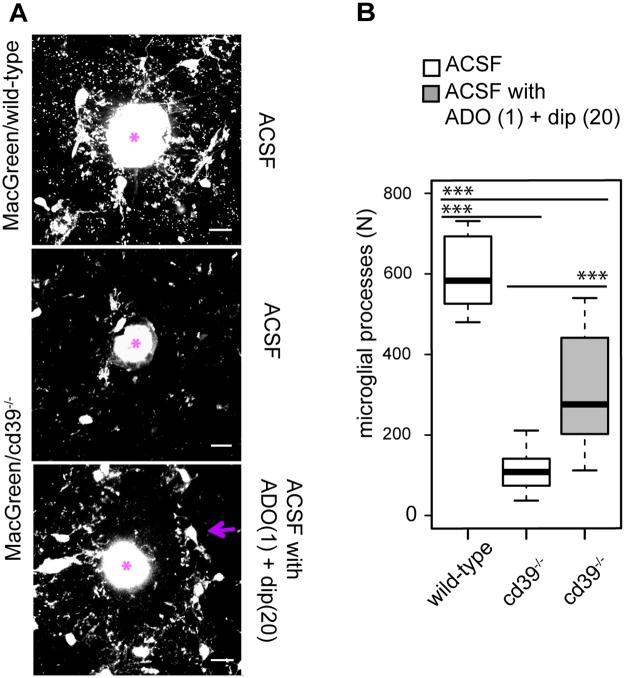
Extracellular adenosine is required for a directional movement of microglial processes towards a focal laser lesion in acute brain slice.(A) Accumulation of microglia processes around a focal laser lesion in an acute brain slice derived from MacGreen/wild-type andMacGreen/cd39-/- mice was studied using confocal microscopy; after a laser lesion was set a brain slice was incubated either with ACSF alone (ACSF) or with ACSF supplemented with adenosine (ADO, 1 μM) and dipyridamole (dip, 20 μM). A laser lesion was set as marked by asterisk. Scale bar 15 μm. (B) Box-plot shows the absolute number of microglial processes that were accumulated around a laser lesion spot in slices from MacGreen/wild-type mice (lesions, n = 9) and in slices from MacGreen/cd39-/- mice in the presence of ACSF alone (lesions, n = 17; white box) and in ACSF supplemented with adenosine (ADO, 1 μM) and dipyridamole (dip, 20 μM) (lesions, n = 15) (grey box); black lines show the median of the data. Significant difference was tested by one-way ANOVA, *** denotes p < 0.001.